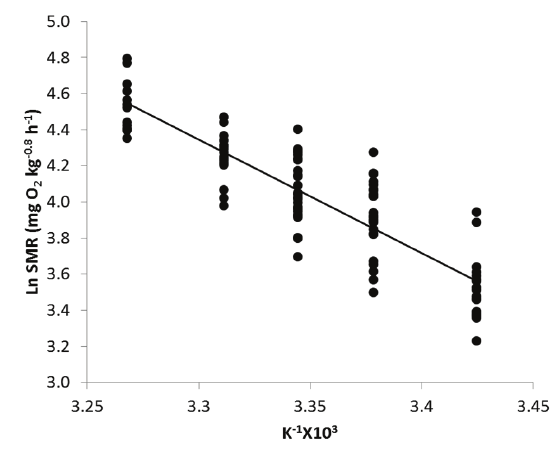
Figure 3 - Arrhenius plot for pacu, where K = absolute temperature. ln SMR = −6.284 × (1/K×10 3 ) + 25.085 (r 2 =